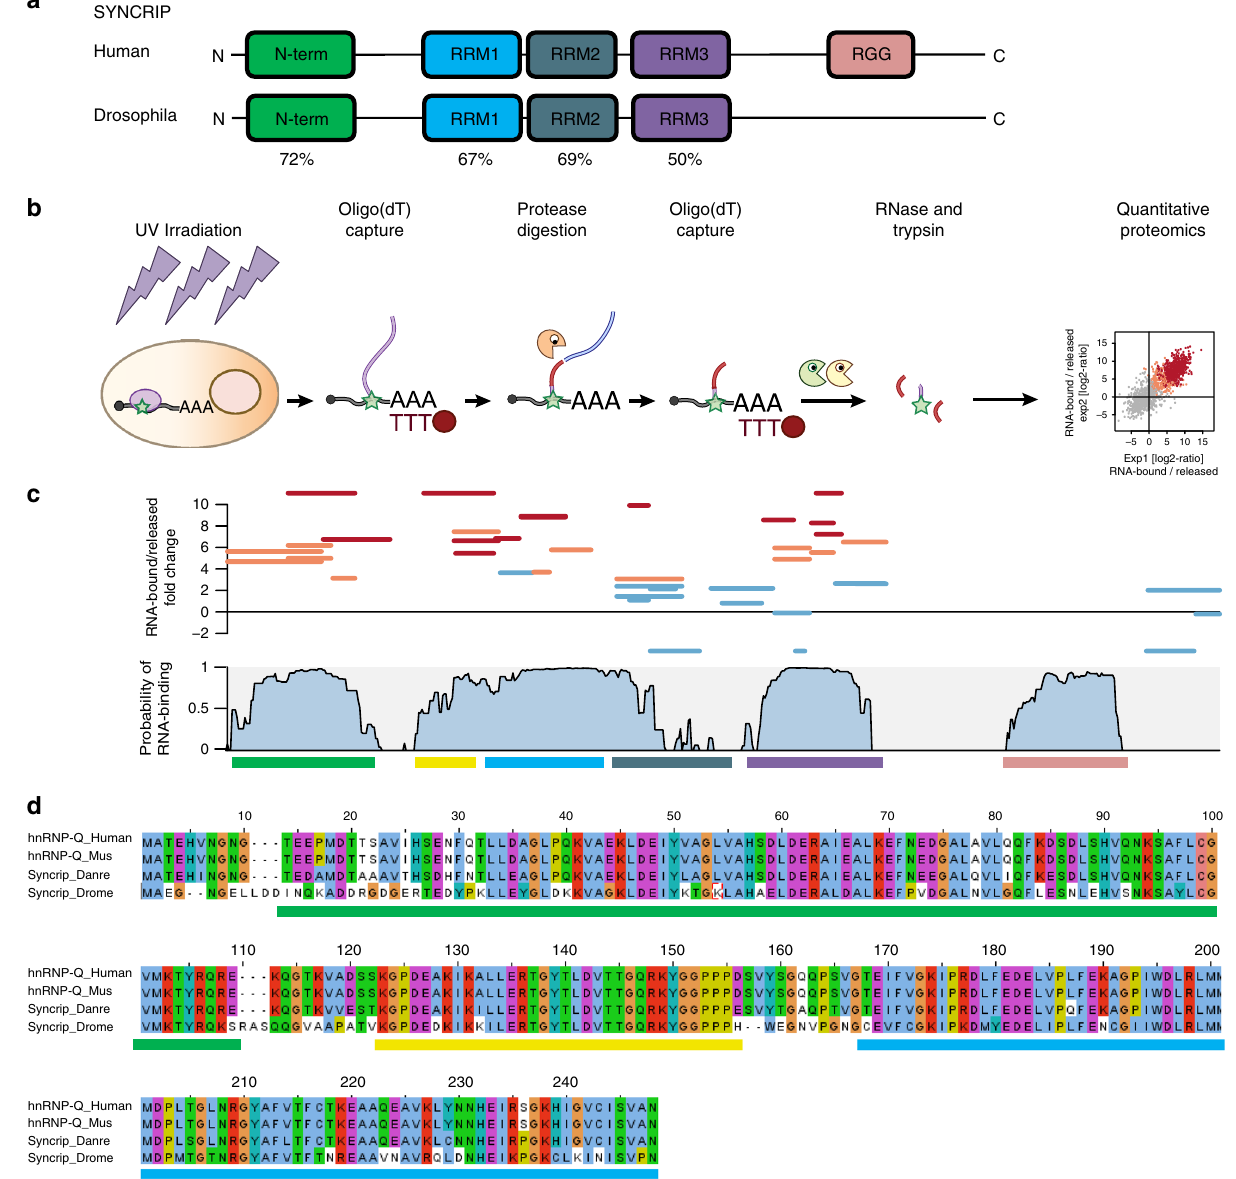
Fig. 1 Syncrip interacts with mRNA targets using multiple RNA-binding domains. a Schematic of the domain organisation and sequence conservation of Syncrip protein from Drosophila and human. The domains are drawn as coloured rectangles and the sequence identity between Drosophila and human individual domains is shown below each equivalent pair. b Work fl ow of the RBDmap assay. c Mapping of the RNA-binding sites detected in human Syncrip by RBDmap. Top: x -axis represents Syncrip from N- to C-terminus. y -axis represent the fold change between the RNA-bound (i.e., peptides crosslinked to RNA) and released (i.e., peptides released to the supernatant after protease treatment) fractions. RNA-bound peptides identi fi ed with FDR < 0.01 are depicted as red lines. Candidate RNA-bound peptides (FDR < 0.1) are depicted in salmon. Peptides released to the supernatant after proteolytic treatment are depicted in cyan. Middle: sequence propensity to bind RNA based on the superset of RNA-bound peptides of human RBPs identi fi ed by RBDmap. This prediction was performed by shrinkage discriminant analysis employing a binary classi fi er, which consists of the sequences of the RNA-bound peptides (positive examples) and that of the peptides lacking RNA-binding activity (negative examples). Resulting algorithm was applied to identify the regions of Syncrip with high probability to interact with RNA. Bottom: lines indicate the different domains of Syncrip, as a reference. The colour of the line(s) corresponds to the colour of the domains in panel a . In addition, the conserved RNA-binding sequence N-terminal to the canonical RRM1 fold domain is indicated by a yellow line. d Sequence alignment of the N-terminal region of Syncrip. The coloured lines below the sequences de fi ne the boundaries of the domains as reported in a and was solved by single-wavelength anomalous diffraction (SAD) The structure comprises residues G22 – P243 but is missing using a seleno-methionine derivatised protein. The fi nal R work / residues 106 – 120, which form the linker between the N-terminal ‘ acidic ’ and the RRM domains and are likely disordered in the R free are 17.4% and 20.6%, respectively, and details of the struc- ture solution and re fi nement are presented in Supplementary crystal. The N-terminal region is organised as a two-domain unit, Table 2. with the alpha-helical N-terminal ‘ acidic ’ domain connected to a